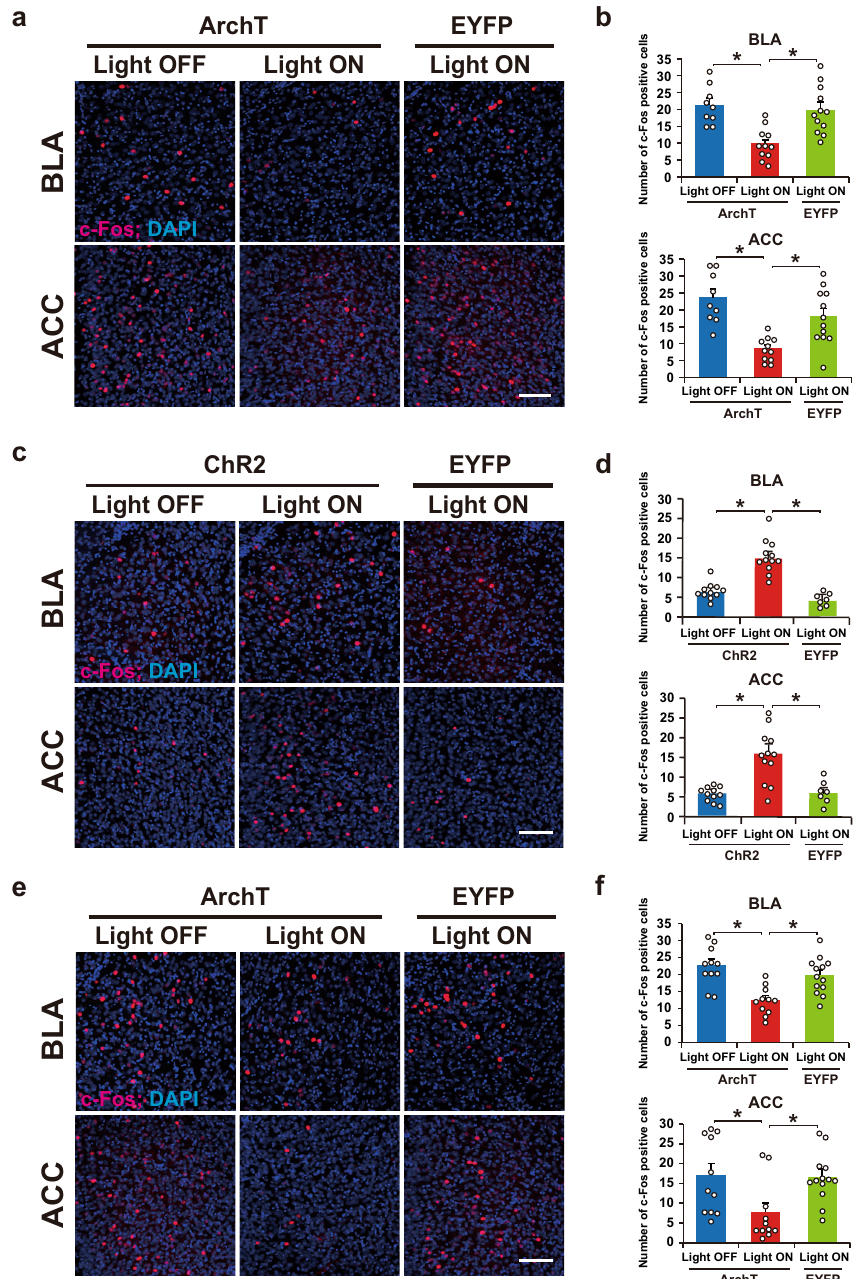
Fig. 6 c-Fos-positive cells in the BLA and the ACC after the test session. a , c , e Representative images of c-Fos expression 90 min after the test shown in Fig. 2b (panel a ), Fig. 3b (panel c ), and Fig. 5b (panel e ). Scale bar, 100 μ m. b , d , f Quantitative proportion of c-Fos-positive cells in the BLA (top) and ACC (bottom) (panel b : ArchT-Light OFF, n = 9 mice, ArchT-Light ON, n = 11 mice, EYFP-Light ON, n = 12 mice; panel d : ChR2-Light OFF, n = 11 mice, ChR2- Light ON, n = 12 mice, EYFP-Light ON, n = 7 mice; panel f : ArchT-Light OFF, n = 11 mice, ArchT-Light ON, n = 11 mice, EYFP-Light ON, n = 13 mice.) (one- way ANOVA followed by Tukey ’ s post hoc tests, panel b : BLA; P = 0.0002, ACC; P < 0.0001, panel d : BLA; P < 0.0001, ACC; P = 0.0002, panel f : BLA; P = 0.0001, ACC; P = 0.0120). Error bars indicate the mean ± s.e.m. * P < 0.05. For details of statistical data, see Supplementary Table 1. Source data are provided as a Source Data fi